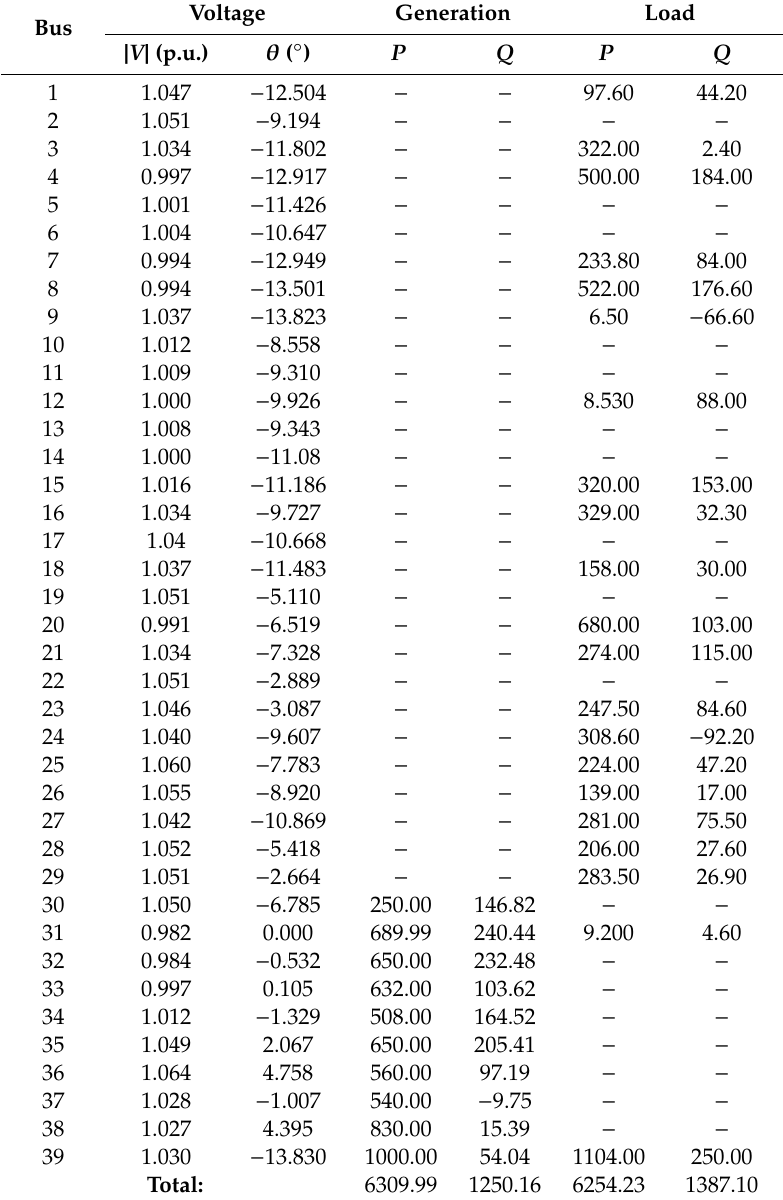
Table A40. Results of Mixed AC / DC PF calculations in Case 7-3. AC bus